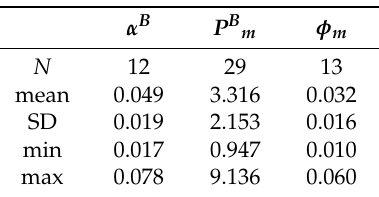
Table 2. Average and range of photosynthetic parameters used in PP PSM and PP Aph : α B [mg C (mg Chl) −